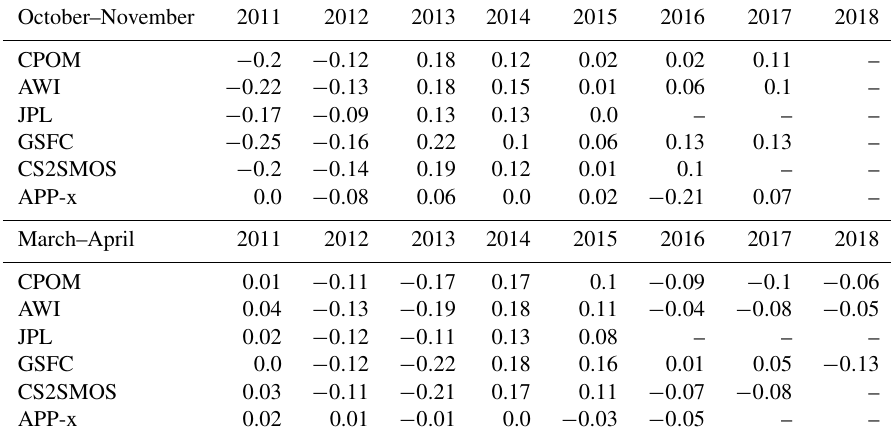
Table 3. Anomalies of seasonally averaged annual sea ice thickness (in m) relative to the seasonally averaged baseline mean within the central Arctic (regions 1–6). The baseline mean is calculated for the period 2011–2015. Anomalies relative to the 2011–2015 mean are included for later seasons according to the product